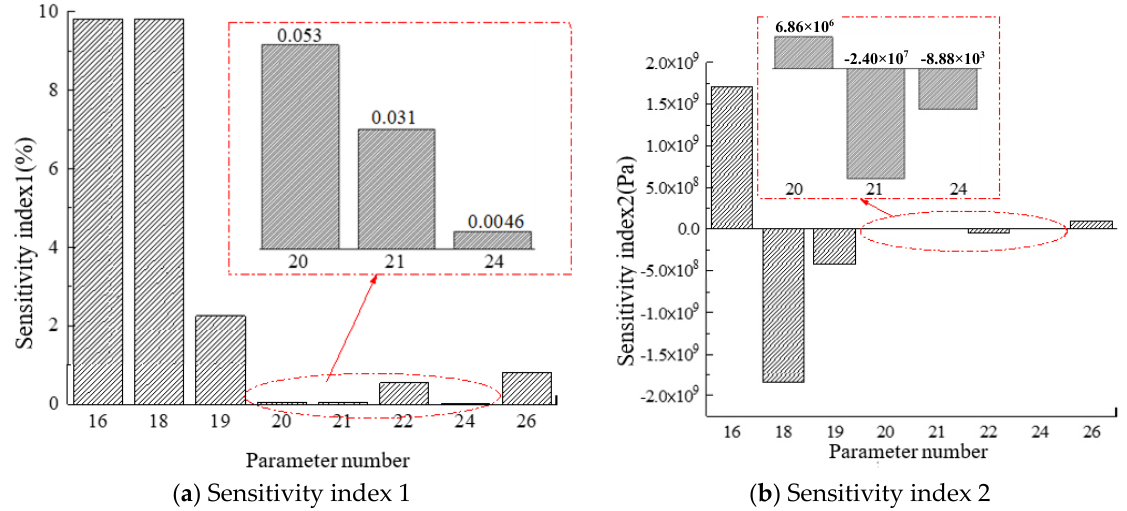
Figure 14. The sensitivity index resulting from power spool part parameter variation.